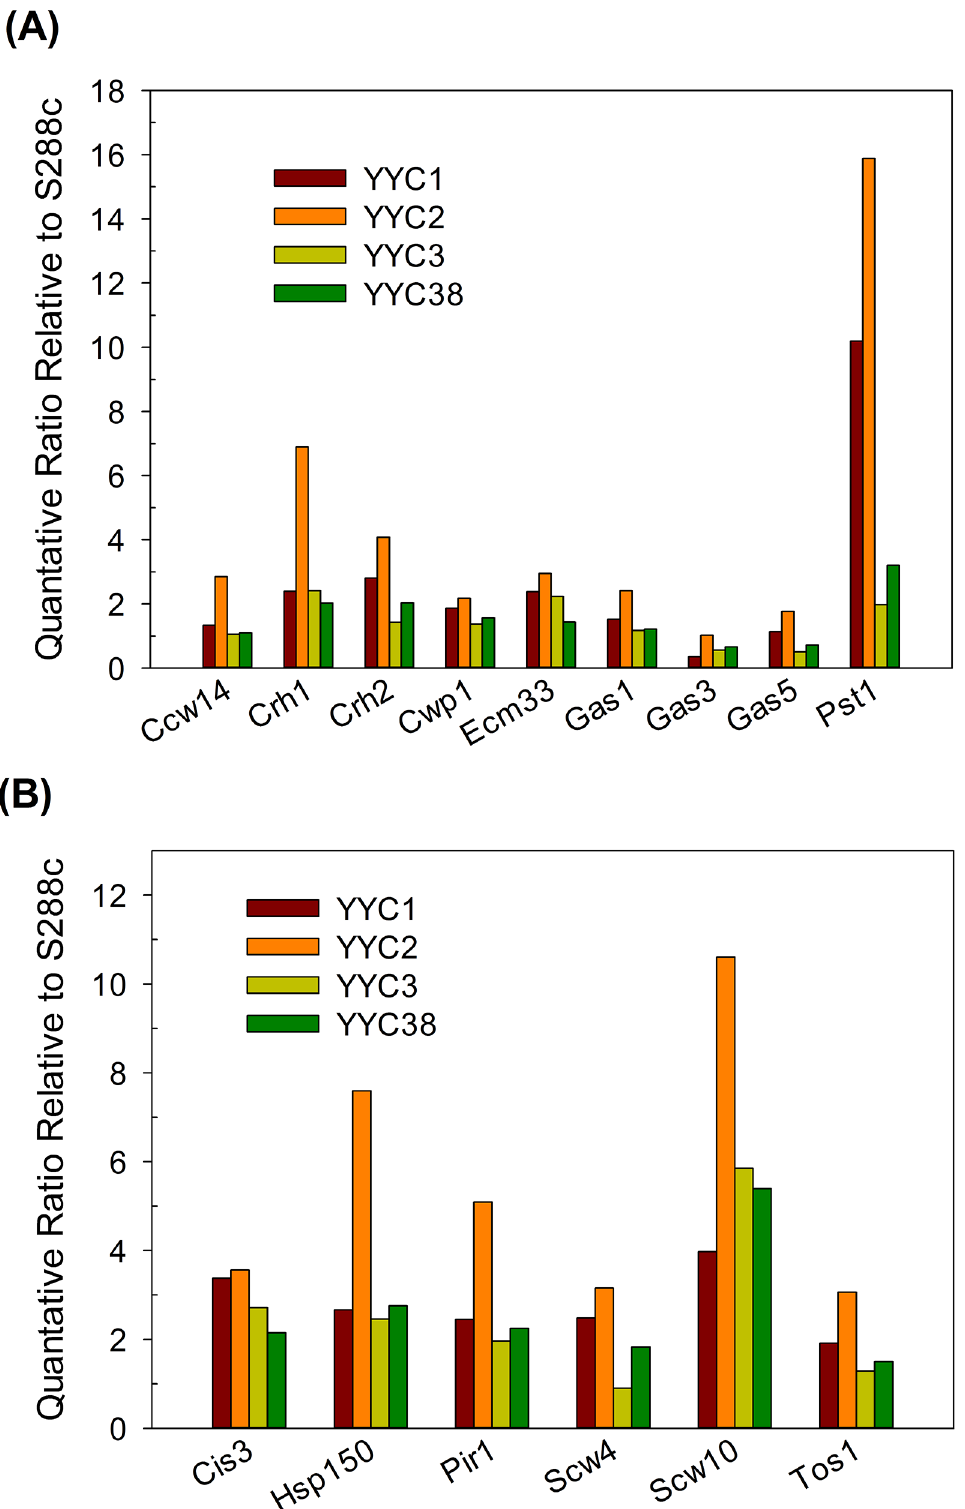
Fig 3. Scw10p, Pst1p and Hsp150p were expressed at significantly higher levels in the clinical isolates than in S288c. The protein levels in clinical isolates (YYC1-3 and 38) relative to S288c strain YYC370 were presented after normalization to the internal controls EF1- α , Pdc1p, and Pma1p. (A) GPI-CWPs and (B) ASL-CWPs. 5 biological replicates were performed and the averages were shown here.